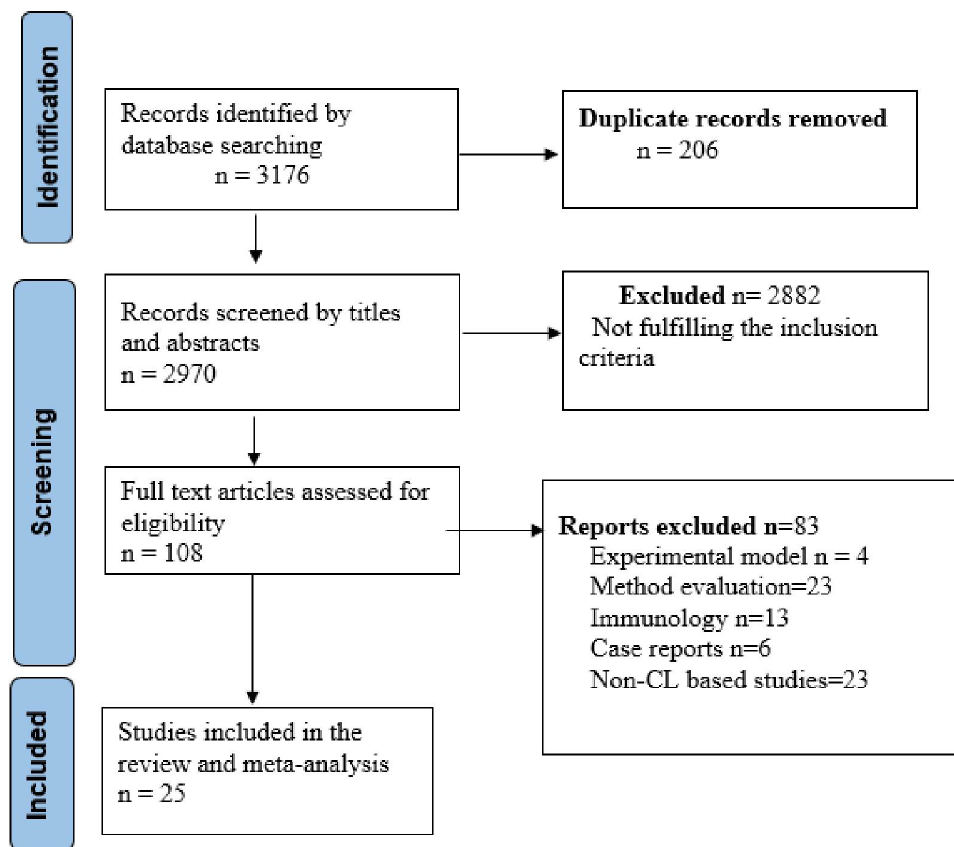
Fig 1. PRISMA flow diagram describing the strategy for article selection for the prevalence of LRV in Leishmania parasites in patients with cutaneous leishmaniasis, 2021.